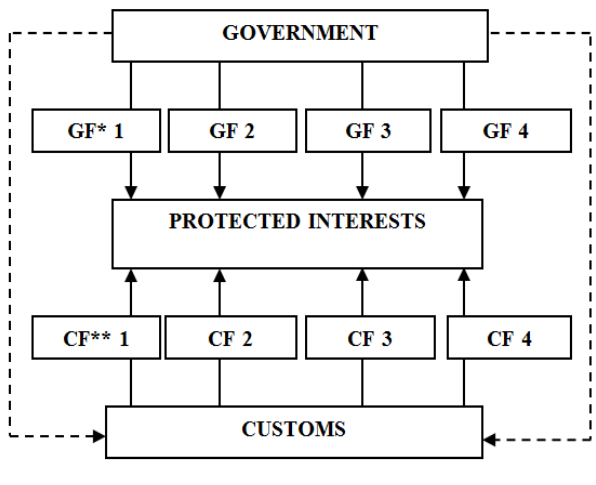
Fig. 1. Interaction of Government and Customs service functions (Cevers,